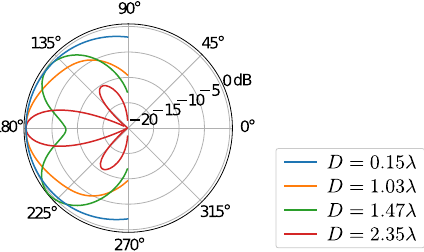
Figure 21. Directivity pattern of the short duct depending on the